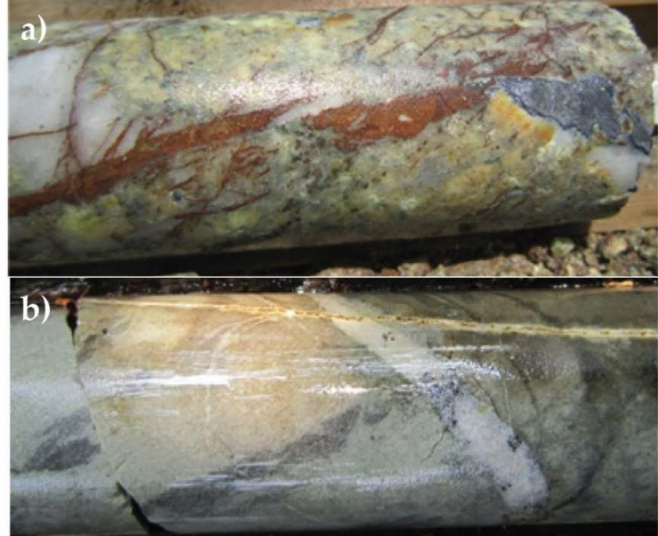
Figure 6. ( a ) Photograph displaying a W-Mo-bearing quartz vein cross-cutting altered granodiorite. ( b ) Photograph displaying a W-Mo-bearing quartz vein (approximately 0.5 cm wide) cross-cutting an altered metasedimentary rock (greywacke). The diameter of the drill core is approximately 5